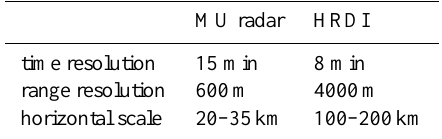
Table 2. Difference in resolution between the MU radar and HRDI MU radar